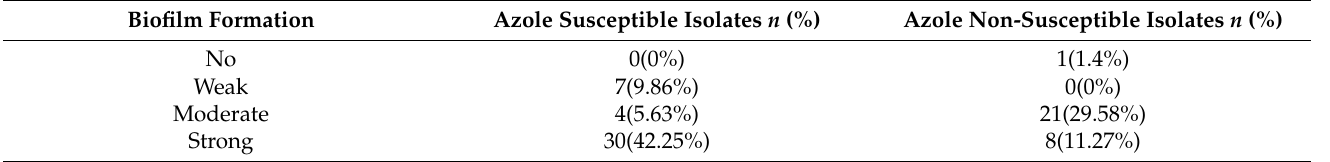
Table 4. Relationship between biofilm production and azole susceptibility.